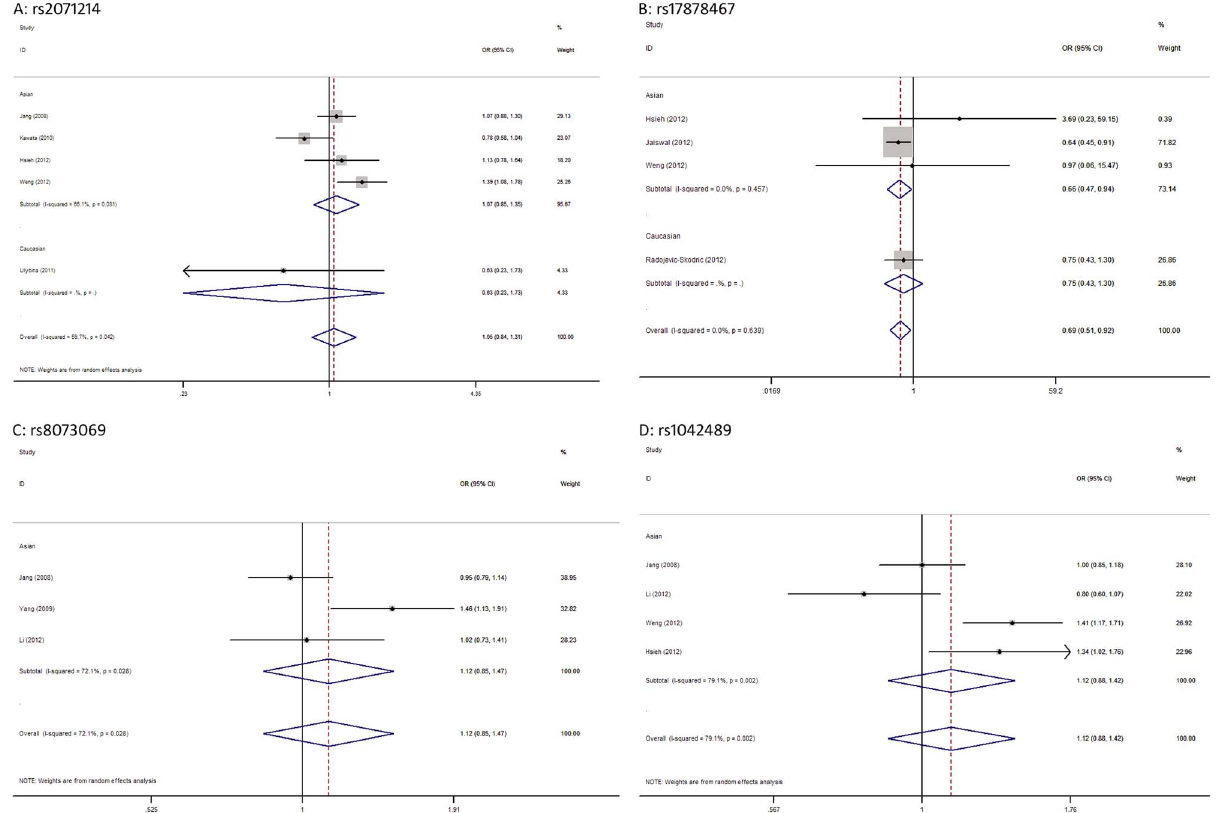
Figure 4. Forest plots of the association of other survivin SNPs with tumor risk under the allele contrast. A: rs2071214, B: rs17878467, C: rs8073069, D: rs1042489.